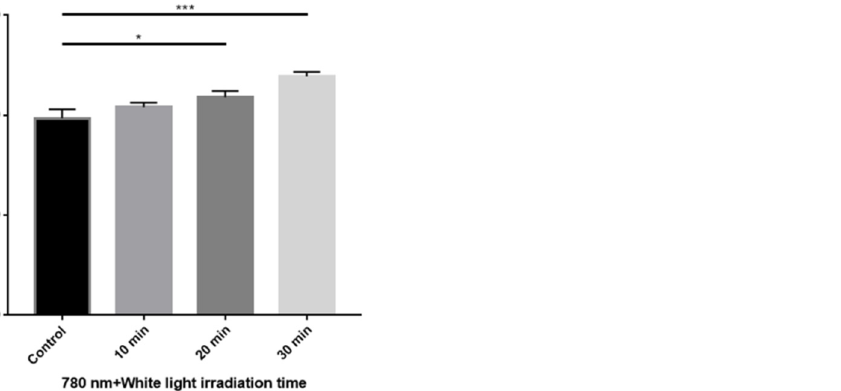
Figure 7. Cell viability by MTT assay by 785 nm LD and white LED irradiation time. *, and *** indi- cates significant differences ( p < 0.05, p < 0.001, respectively).